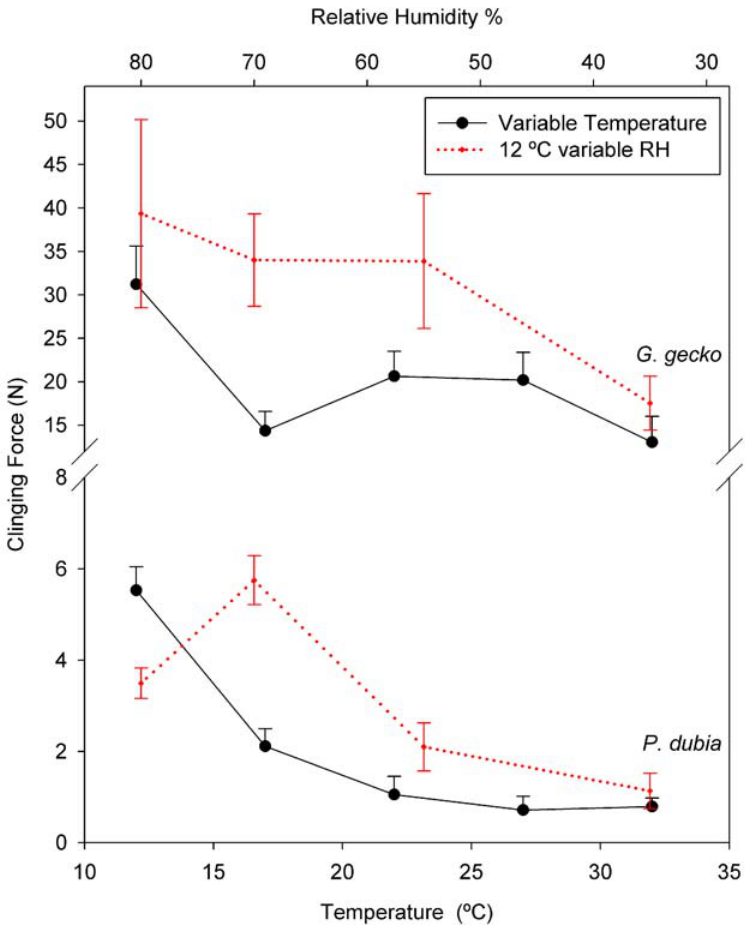
Figure 3. Adhesion during variable temperature, uncontrolled humidity trials (black solid lines), and variable relative humidity constant temperature trials (12 u C; red-dotted lines) showing convergence of maximal clinging force with increasing temperature and decreasing humidity. Error bars are 6 2 SEM.